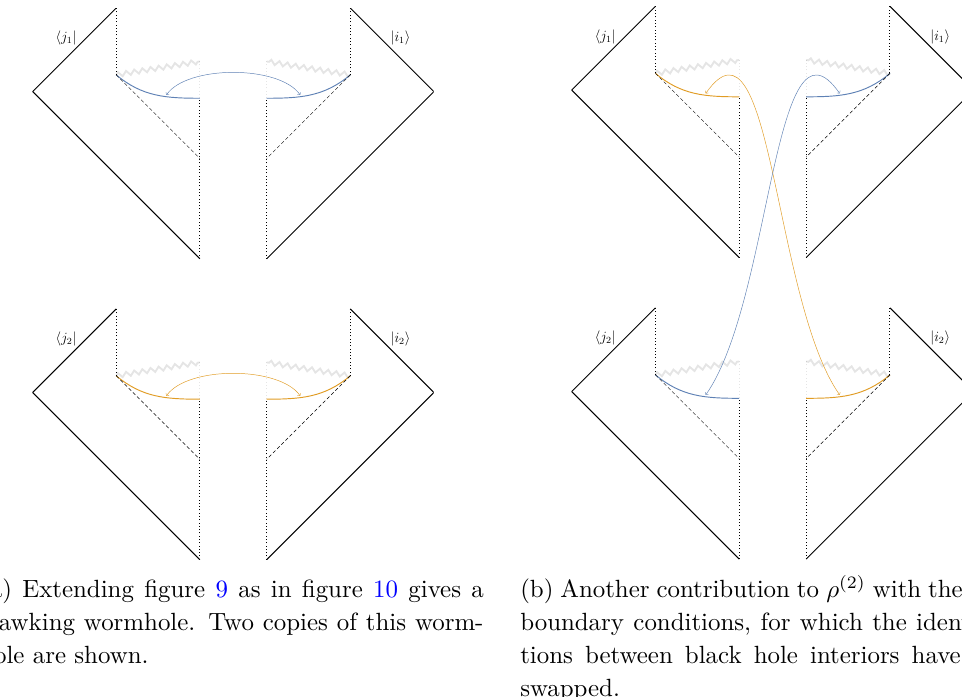
Figure 11. The Hawking (a) and Polchinski-Strominger (b) wormholes contributing to the density matrix ρ (2) describing the decay products at I + of two identically-prepared black